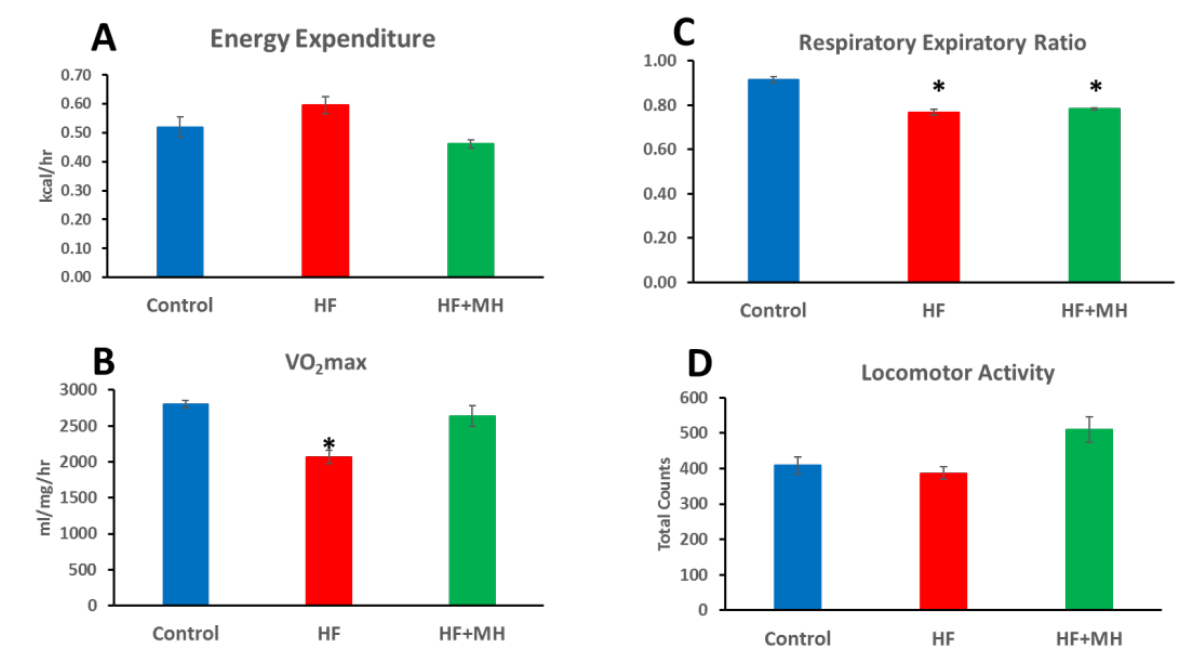
Figure 3. ( A ): Energy expenditure (kcal/hour) over 4 days in CLAMS. ( B ): VO 2 max (oxygen usage) over 4 days in CLAMS. ( C ): Respiratory expiratory ratio over 4 days in CLAMS. ( D ): locomotor activity over 4 days in CLAMS. * = p < 0.01 compared to Control group. (Ns = 4.).